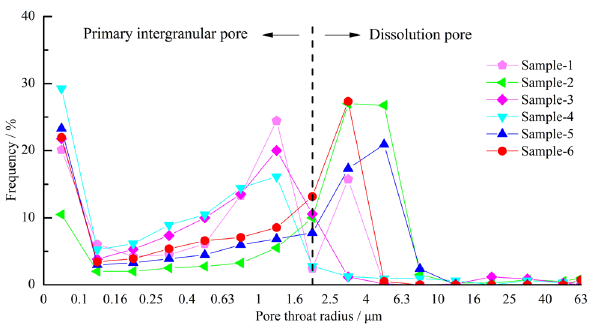
Fig. 12 Distribution law of pore throat radius